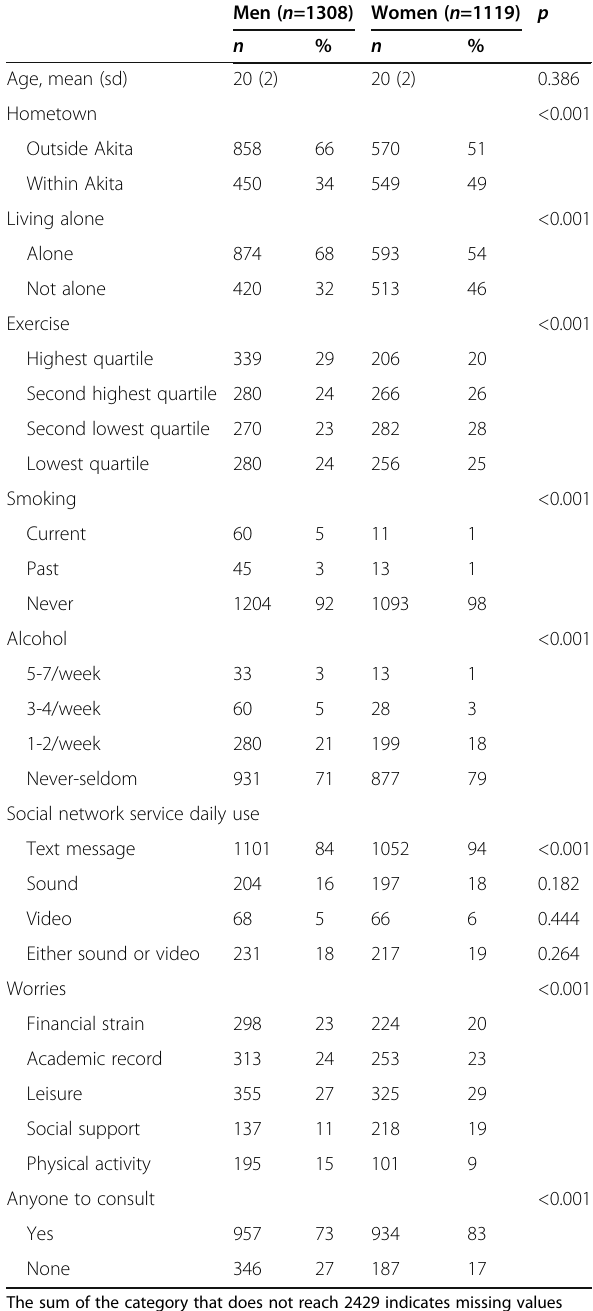
Table 1 Baseline characteristics of enrolled students ( n